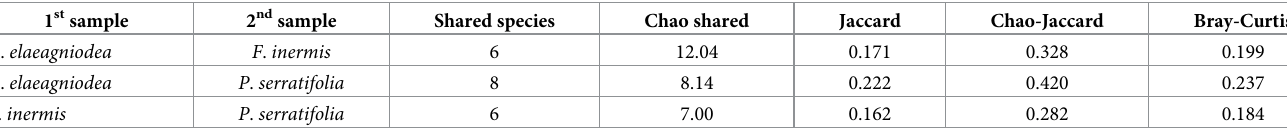
Table 3. Shared species indices of A . elaeagniodea , F . inermis and P . serratifolia . 1 st